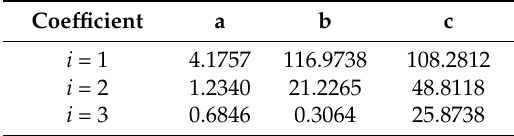
U f SOC based on a Gaussian function trinomial. Table 2. The coefficients for = ( ) OCV Table 2. The coefficients for U OCV = f ( SOC ) based on a Gaussian function